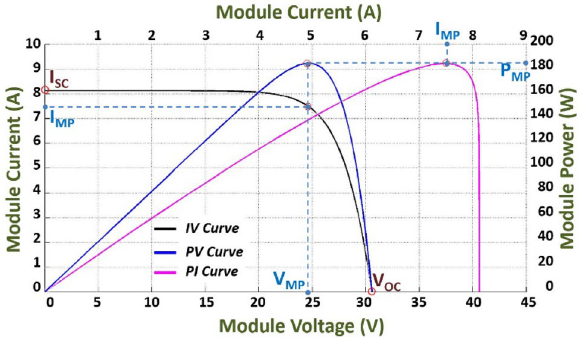
Figure 1. Mitsubishi Electric PV-TD185MF5 (185 Wp) PV module electrical characteristic.